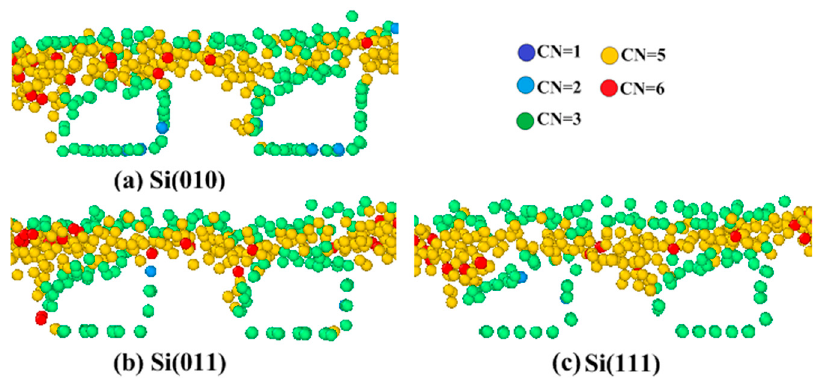
Figure 11. Effects of anisotropy on pore walls at polishing depth of 1.0 nm. Figure 11. E ff ects of anisotropy on pore walls at polishing depth of 1.0